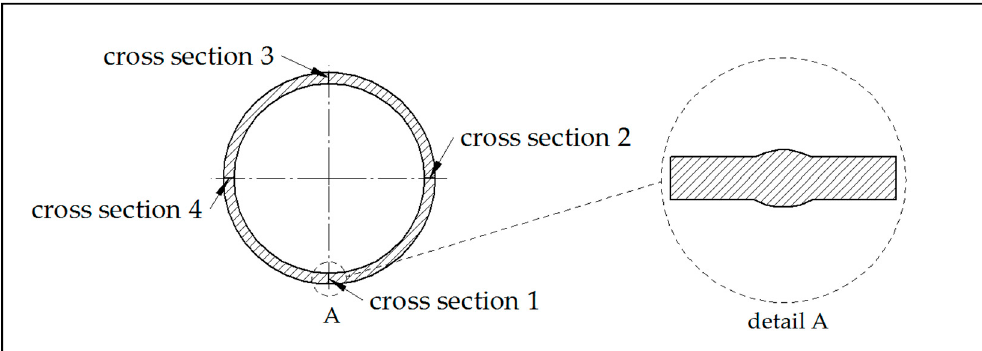
Figure 1. Position and orientation of cross sectioned locations for porosity measurement.